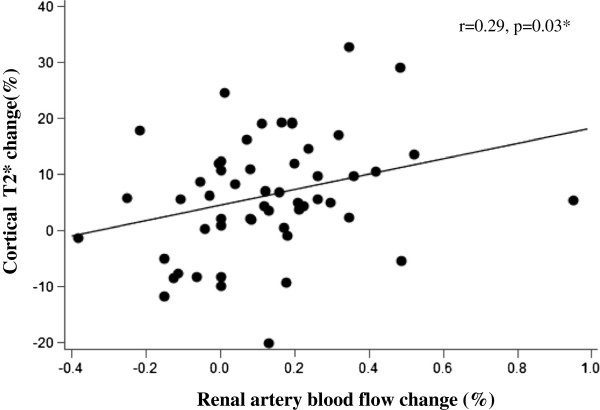
Scatter plot demonstrating the relationship between percentage change in renal artery blood flow and percentage change in renal cortical T2* values (x-axis) after 20 mg intravenous furosemide (y-axis). The regression line, Pearson’s correlation coefficient, and p-value are displayed.